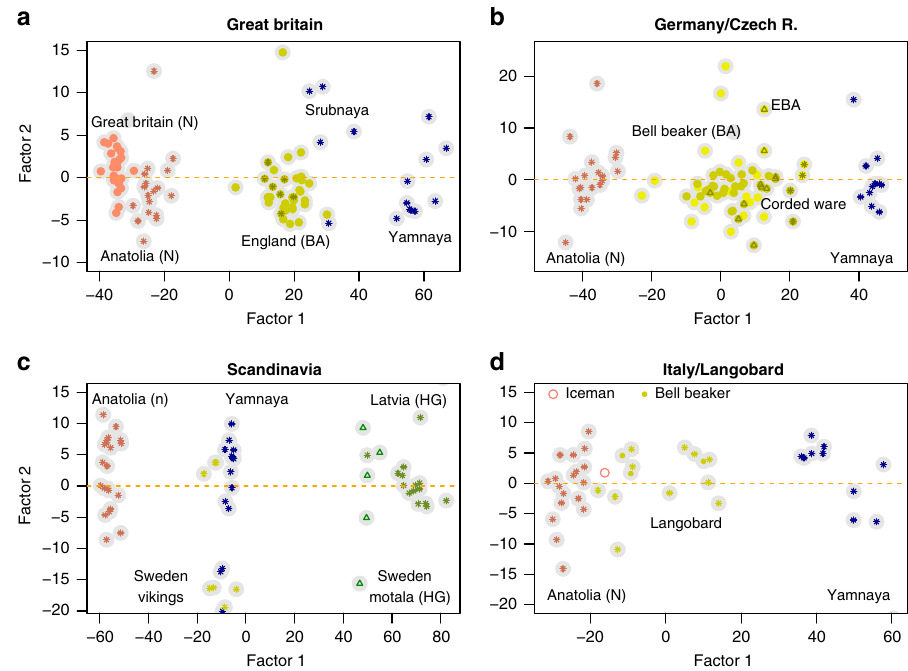
Fig. 5 Factor analysis by regions. Multi-population FA in four regions of Europe. a Bronze Age and Neolithic Great Britain, continued from Fig. 3, b Bronze Age Germany and Czech Republic (star: Corded Ware, triangle: EBA), c Prehistoric and early Middle-Ages Scandinavia (triangles represent Swedish HG from Motala), d Bronze Age and Roman Italy. HG: Hunter-Gatherers, N: Neolithic, BA: Bronze